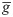
Triphasic response pattern reproduced by the MGC model in response to a pheromone stimulus (500 ms, 10ng).In the results shown in A to D, for most parameters in Eqs (4–14), we used the original values from literature given in Tables 2–4 except for some values that were modified (modified values in Tables 2–4). A. Spikes of one ORN (blue lines) and mean firing frequency curve of ORNs (red line). B. Dynamics of the PN membrane potential V. C. Spikes of the PN (blue lines) and PN firing frequency (red line). D. Kinetics of intracellular Ca2+ concentration of the PN. E. Spikes of the PN (blue lines) and PN firing frequency (red line) (g-
A = 0 μS, g-
Ca = 0.045 μS). F. Dynamics of the PN membrane potential V (g-
A = 0 μS, g-
Ca = 0.045 μS). G. Spikes of the PN (blue lines) and PN firing frequency (red line) (g-
A = 0.5 μS, V
0.5actA = -40.0 mV, g-
Ca = 0.045 μS). H. Dynamics of the PN membrane potential V (g-
A = 0.5 μS, V
0.5actA = -40.0 mV, g-
Ca = 0.045 μS). I. Spikes of the PN (blue lines) and PN firing frequency (red line) (g-
A = 0.5 μS, V
0.5actA = -37.0 mV, g-
Ca = 0.035 μS). J. Dynamics of the PN membrane potential V (g-
A = 0.5 μS, V
0.5actA = -37.0 mV, g-
Ca = 0.035 μS).